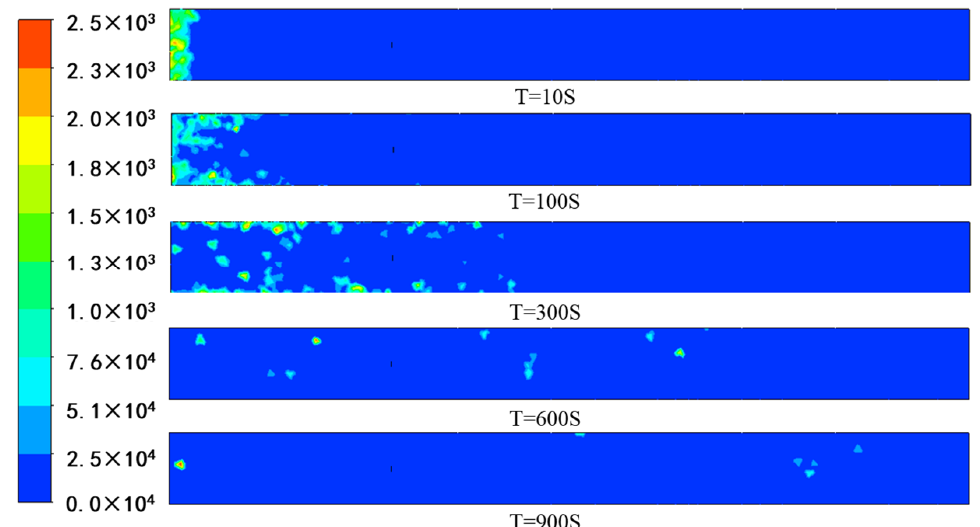
Figure 3. Wind speed body of the tunnel space.